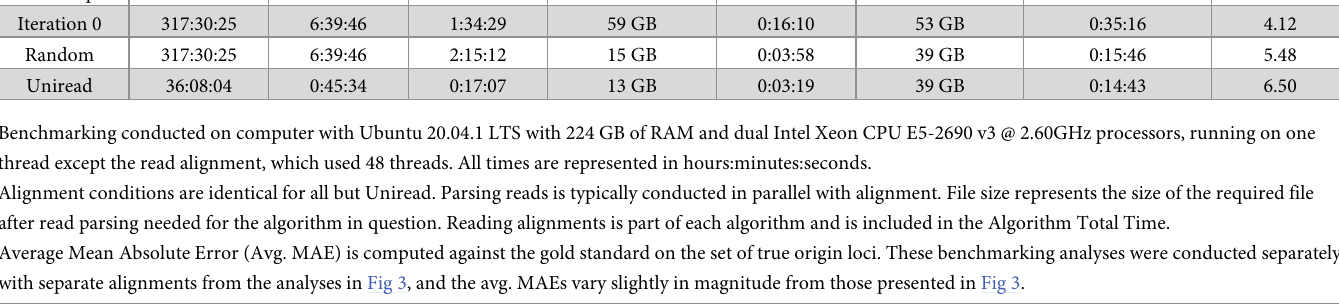
Table 8. Benchmarking SmartMap software. Pre-algorithm alignment and